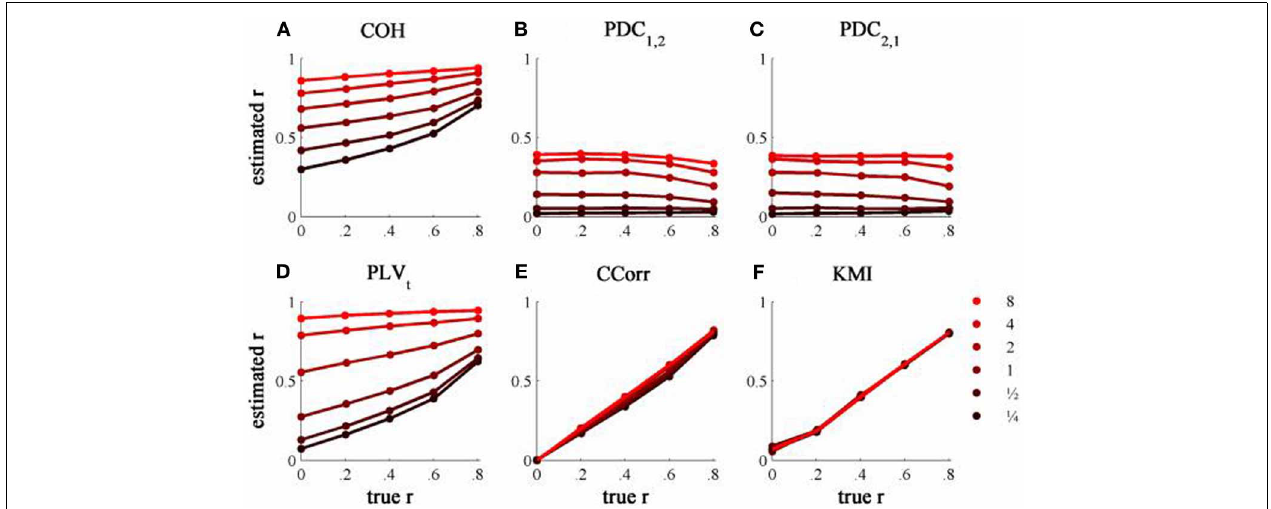
FIGURE 5 | The relationship between the true and estimated coupling for each measure of connectivity for the zero-lagged simulated data at different levels of concentration, κ . (A) Shows coherence, (B,C) partial